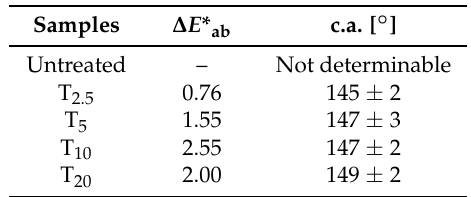
Table 2. Colour difference ( ∆ E * ab ) and water-stone static contact angle (c.a.), with the related maximum deviation, before and after the treatments.